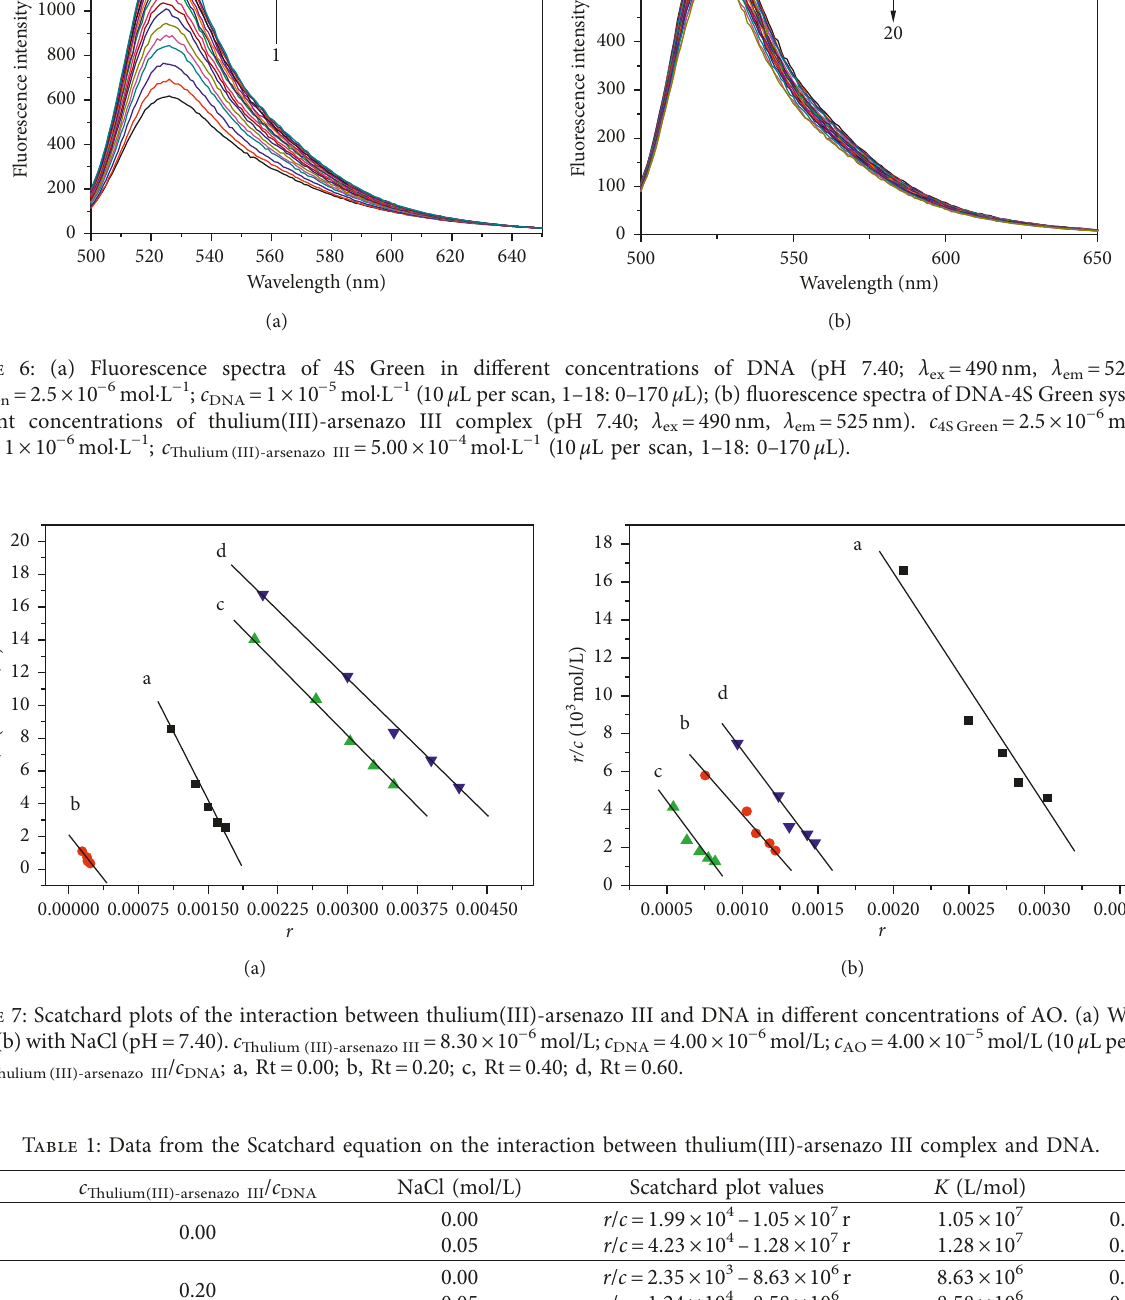
490 nm, λ em (cid:31)